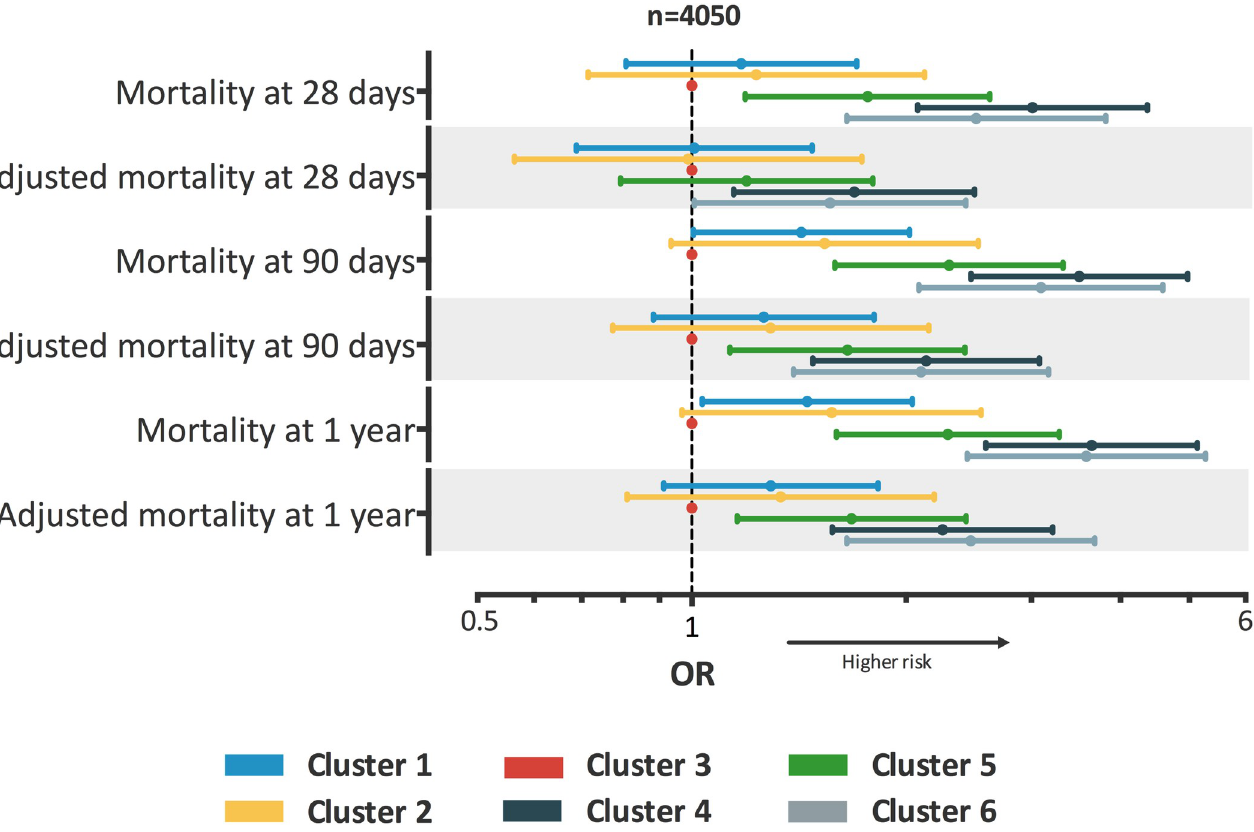
Fig 3. Description of the clusters and their risks of early, intermediate and late mortality, with and without adjustment (performed in training set). Definition of abbreviations : HR: Hazard ratio; The analysis was performed after exclusion of patients without septic shock. A Cox model was used to determine the hazard ratio; Data are reported as HR ± 95% confidence intervals, presented from lowest to highest;presented from lowest to highest; Cluster 3 was used as reference; Adjusted mortality were adjusted using SOFA score at admission and year of ICU admission. Cluster 1 = young patients without any comorbidities, admitted in ICU for community-acquired pneumonia; Cluster 2 = young patients without any comorbidities, admitted in ICU for meningitis or encephalitis; Cluster 3 = elderly patients with COPD, admitted in ICU for bronchial infection with few organ failures; Cluster 4 = elderly patients with several comorbidities and organ failures; Cluster 5 = patients admitted after surgery with a nosocomial infection; Cluster 6 = young patients with immunosuppressive disease or therapy such as AIDS, chronic steroid therapy or hematological